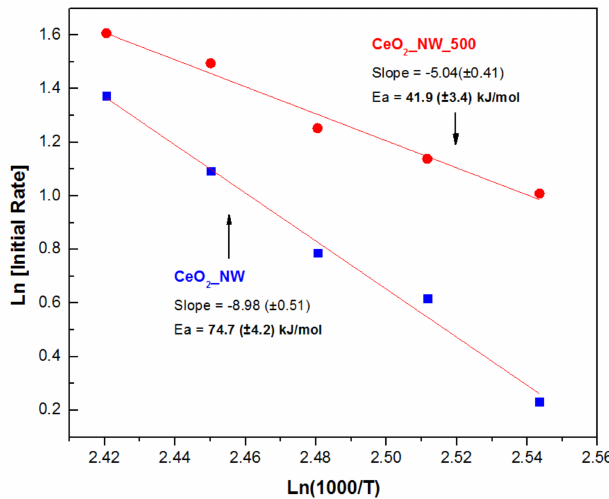
Figure 7. Arrhenius plot for direct synthesis of DMC over CeO 2 _NW_500 and CeO 2 _NW catalyst.